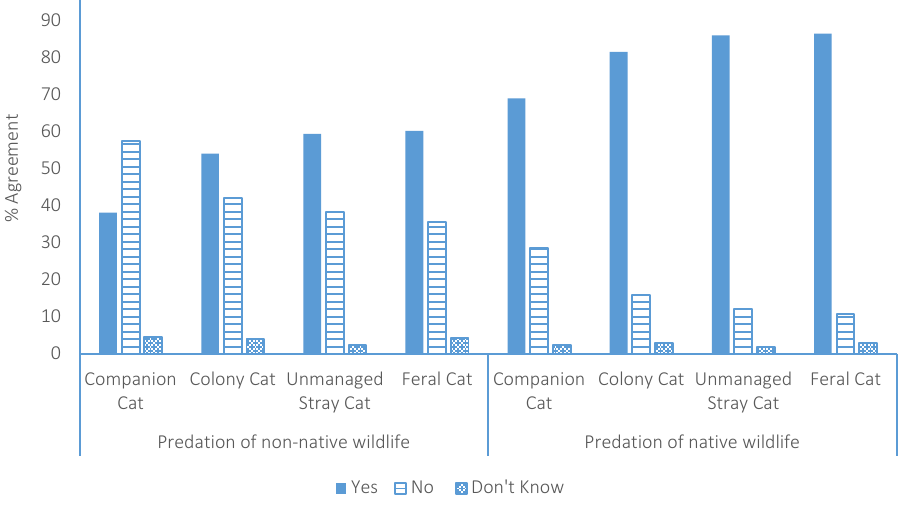
Figure 1. Participant concern about the predation of non-native and native wildlife by each sub group of cat in New Zealand.